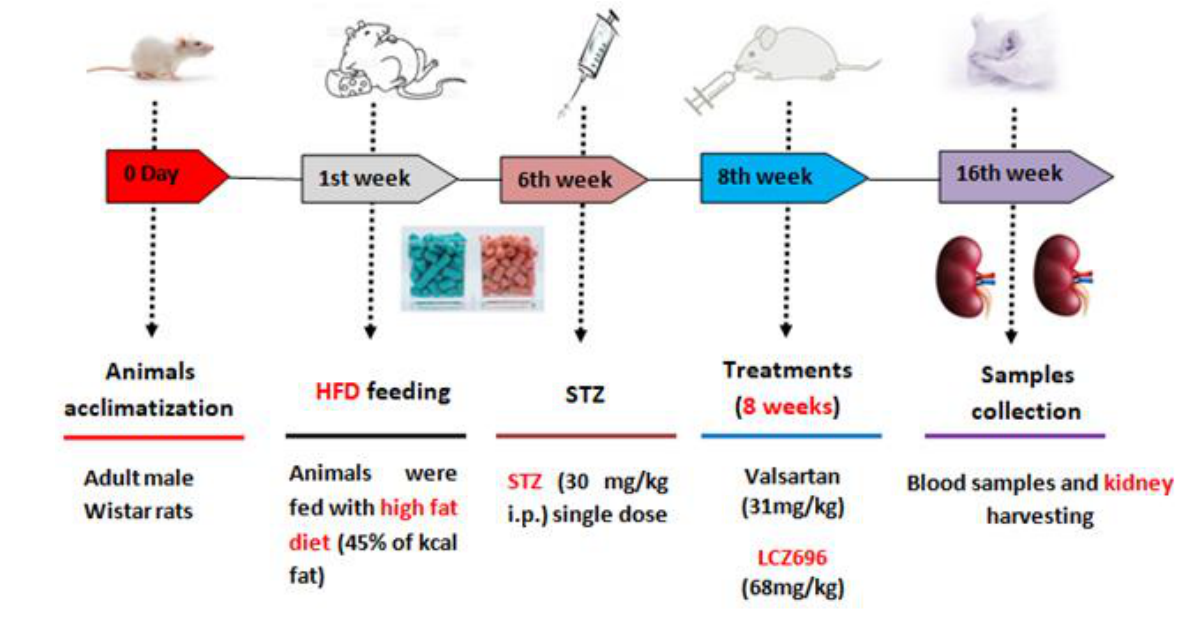
Figure 1. Diagram illustrating the experimental design.